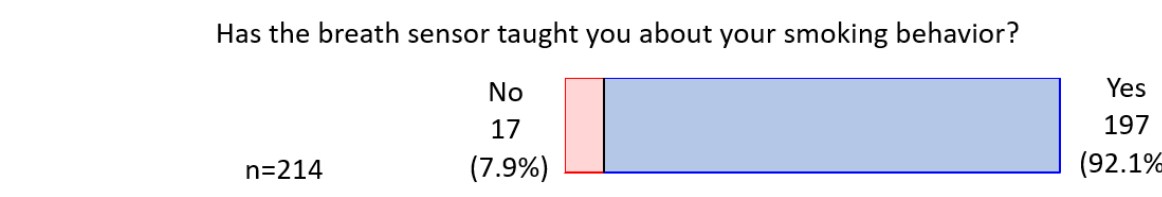
Figure 12. Participant Feedback: Has the breath sensor taught you about your smoking behavior? (week 3).